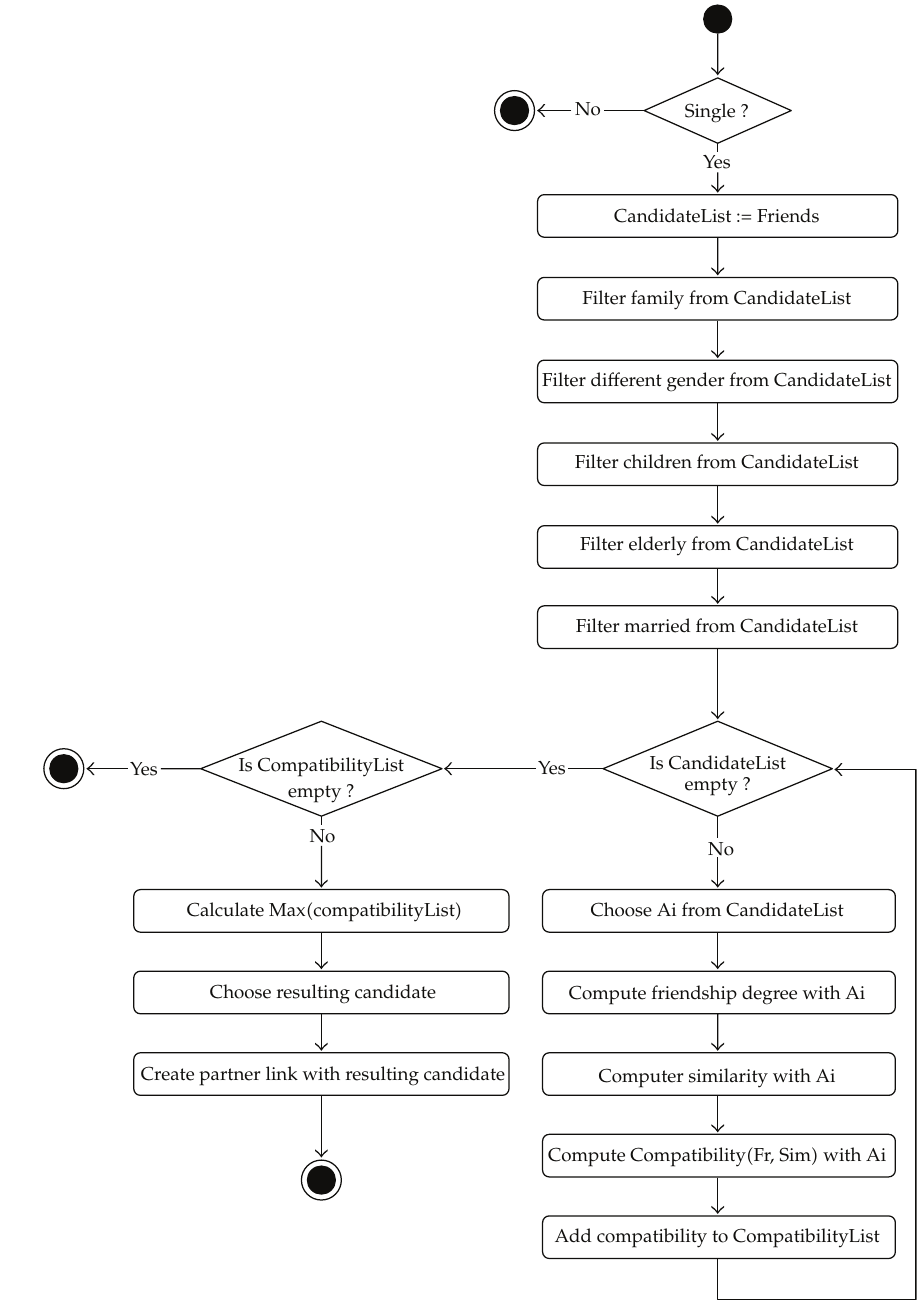
Figure 2: Flow diagram summarising the process of partner finding (cid:5) matchmaking (cid:6)